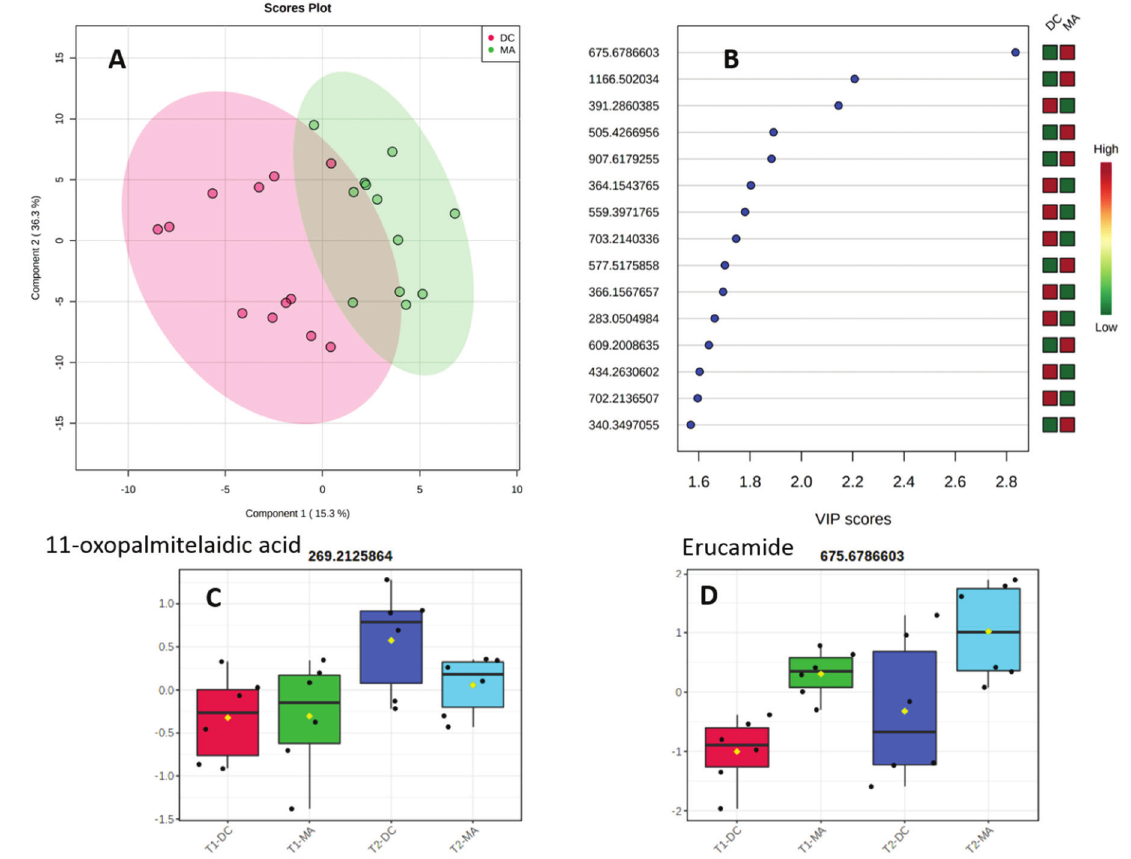
Figure 3. ( A ) Partial least-squares-discriminant analysis (PLS-DA) of the metabolome of the cyanobacteria on macroalga (MA) or dead corals (DC). ( B ) Variable importance in the PLS-DA (VIP) responsible for the discrimination and their scores. ( C ) Relative area of 11-oxopalmitelaidic acid ( m / z 269.2126) in the four conditions. ( D ) Relative area of erucamide ( mz 675.6787) in the four conditions.